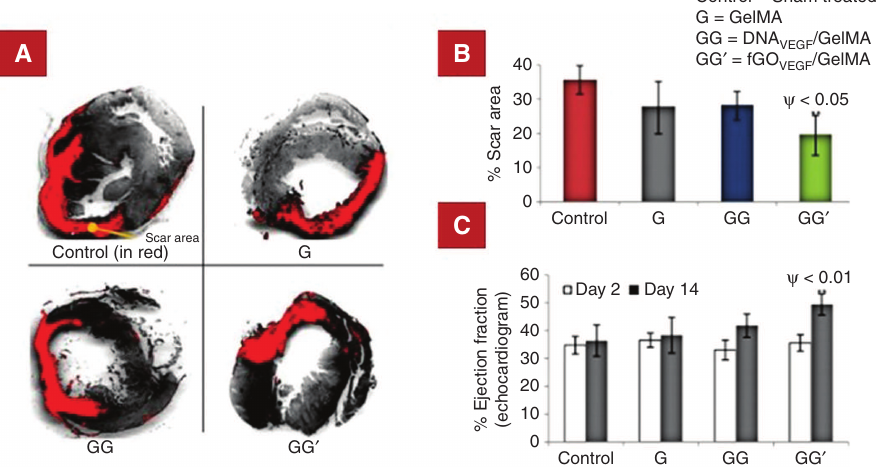
Figure 4: The assessment of the in vivo scar areas and cardiac function of infarcted hearts treated with GG‘ hydrogel (GelMA hydrogel carrying fGO VEGF (pDNA VEGF bound to fGO)) therapy. (A) and (B) The scar area determination by morphometric analysis of the left ventricle in different groups. The representative images of the left ventricle myocardial sections stained with sirius red show the cardiac fibrosis regions (in red). Sham operated and untreated infarcted group were used as controls. The red area represents the ECM deposition in the scar tissue and the gray area represents the myocardium. (C) Echocardiographic assessment of cardiac function. The heart ejection frac- tion (EF%) was monitored at days 2 and 14 post-treatment. p < 0.0001; ***p < 0.001, **p < 0.01, *p < 0.05 vs. time-matched control (n = 7). The p-values comparing time-matched GG′ and GG are indicated by ψ. This is an unoflcial adaption of Ref. [9] that appeared in an ACS publication. ACS has not endorsed the content of this adaption or the context of its use.